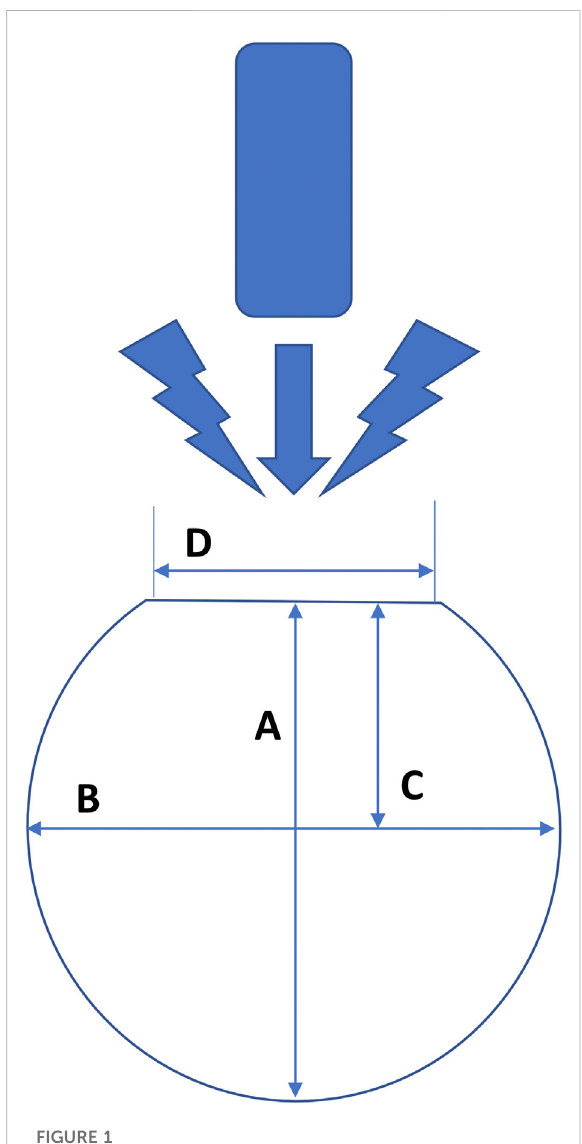
FIGURE 1 Schema of measuring the dimensions of lesions formed after radiofrequency ablation in the left ventricle of the swine hearts. (A) = maximum depth, (B) = maximum width, (C) = depth at the maximum diameter and (D) = lesion surface diameter ( “ estuary ” ). Themeasurement of eachlesiontakesplace where the lesion reaches its maximum